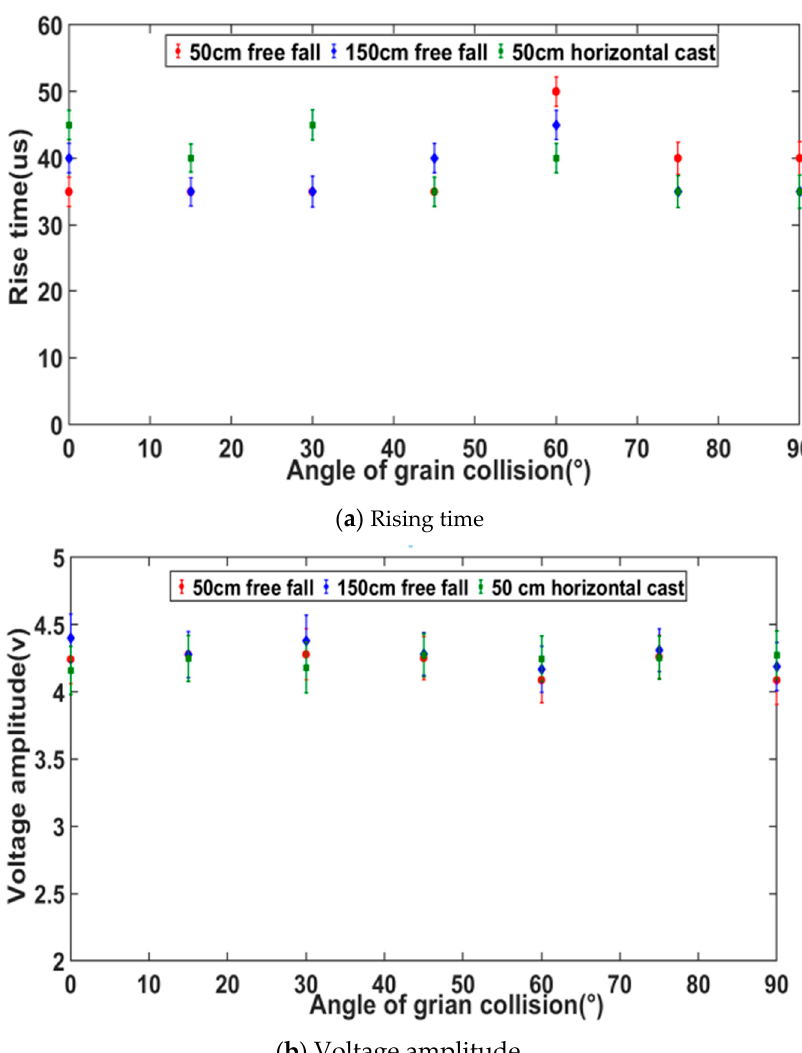
Figure 10. Effects of collision velocity on signal rise time and voltage amplitude .